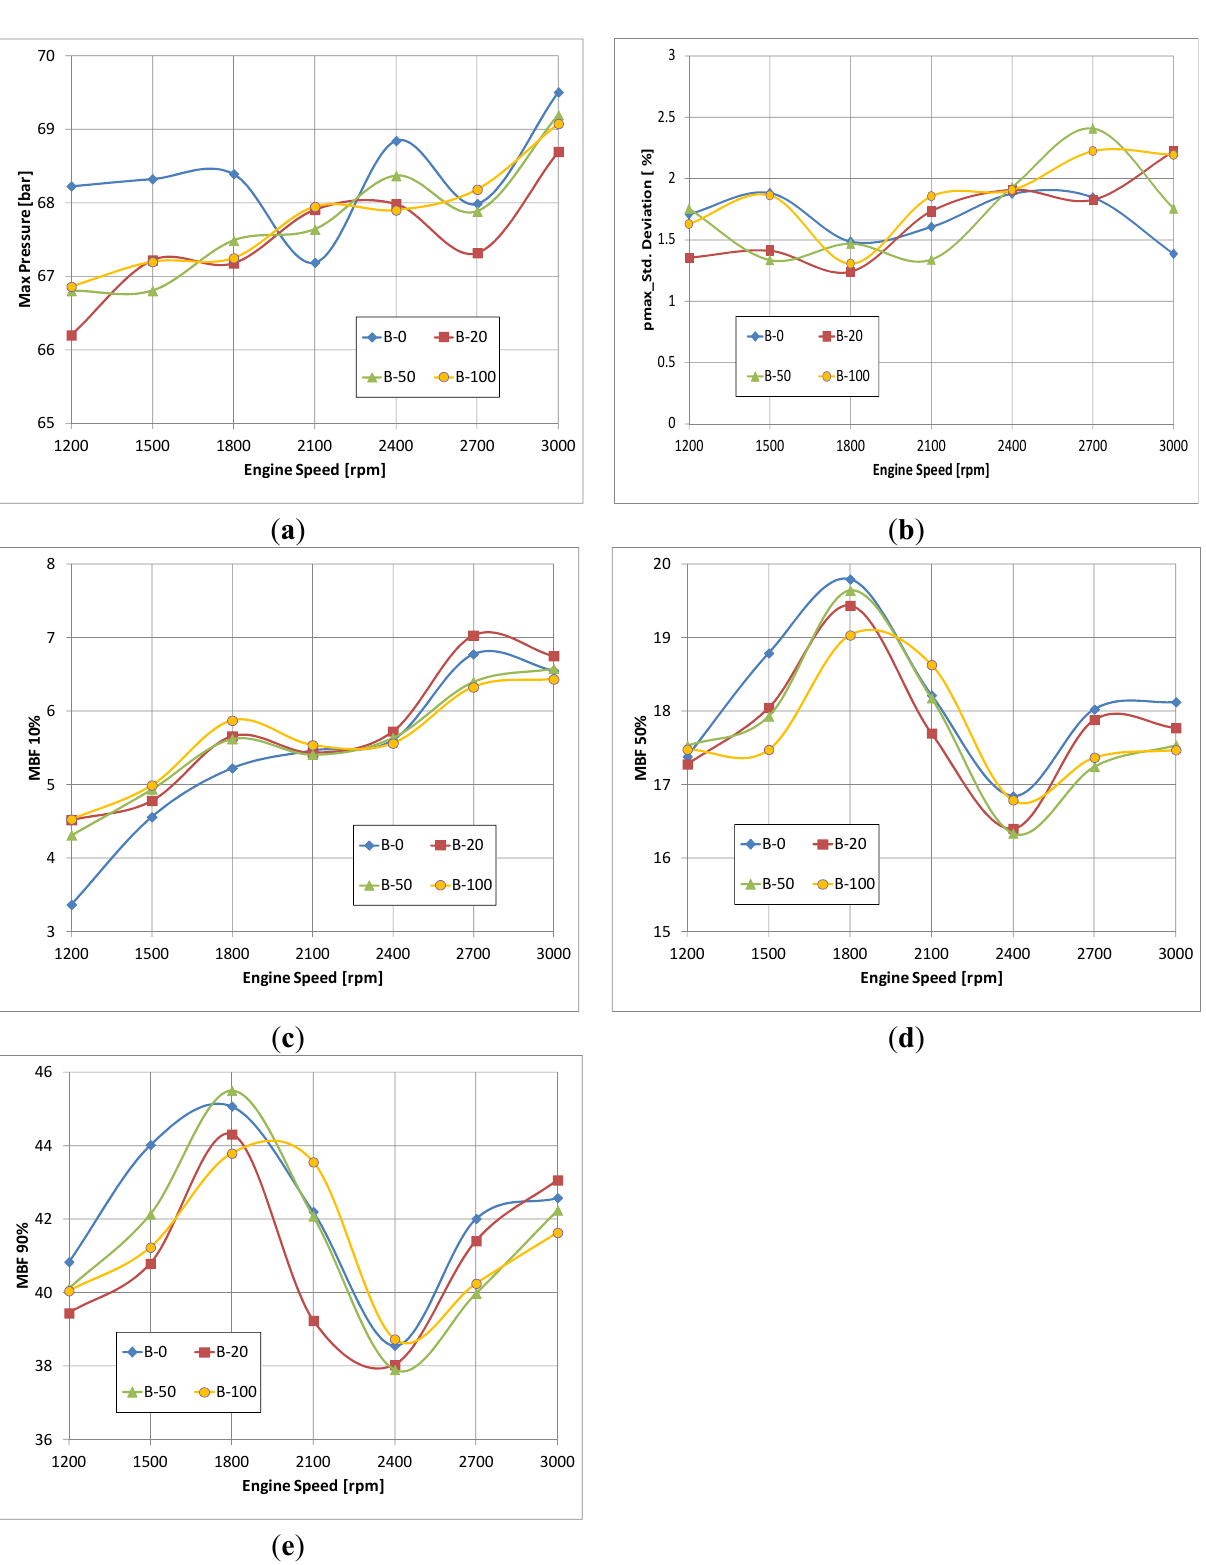
Figure 3. Combustion parameter as a function of engine rotational speed ( a ) in-cylinder peak pressure; ( b ) in-cylinder peak pressure standard deviation; ( c ) crank angle for 10% mass fraction burn; ( d ) crank angle for 50% mass fraction burn; ( e ) crank angle for 90% mass fraction